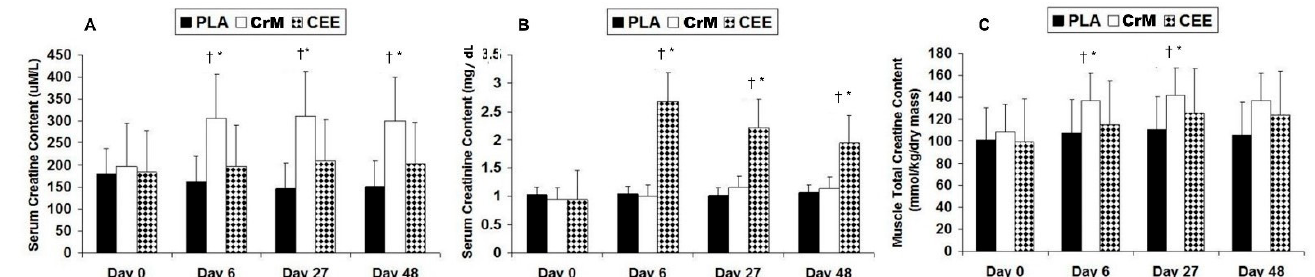
Figure 10. Serum creatine ( A ), serum creatinine ( B ), and muscle creatine content ( C ). * Represents significant change from baseline. † in panel A indicates significantly higher serum creatine concentra- tions in CrM when compared to PLA ( p = 0.007) and CEE ( p = 0.005). † in panel B indicates serum creatinine in the CEE group was greater than PLA ( p = 0.001) and CrM ( p = 0.001). † in panel C shows the PLA group was significantly less than the CrM ( p = 0.026) and CEE ( p = 0.041) groups. Adapted from Spillane et al. [27] .